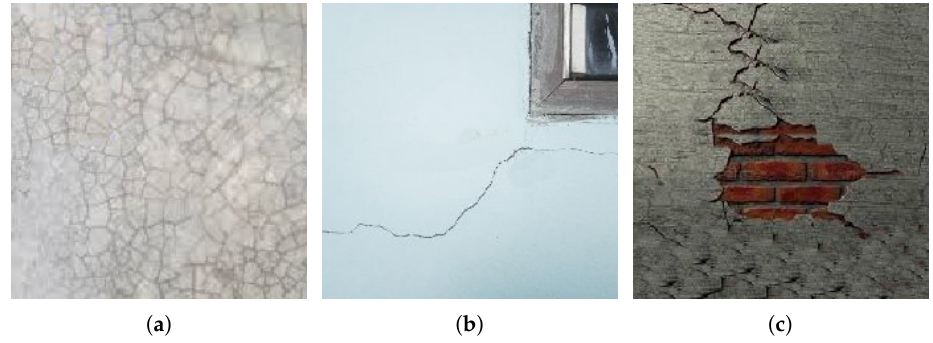
Figure 3. Example of collected images from web scrapping: ( a ) light; ( b ) medium; ( c )